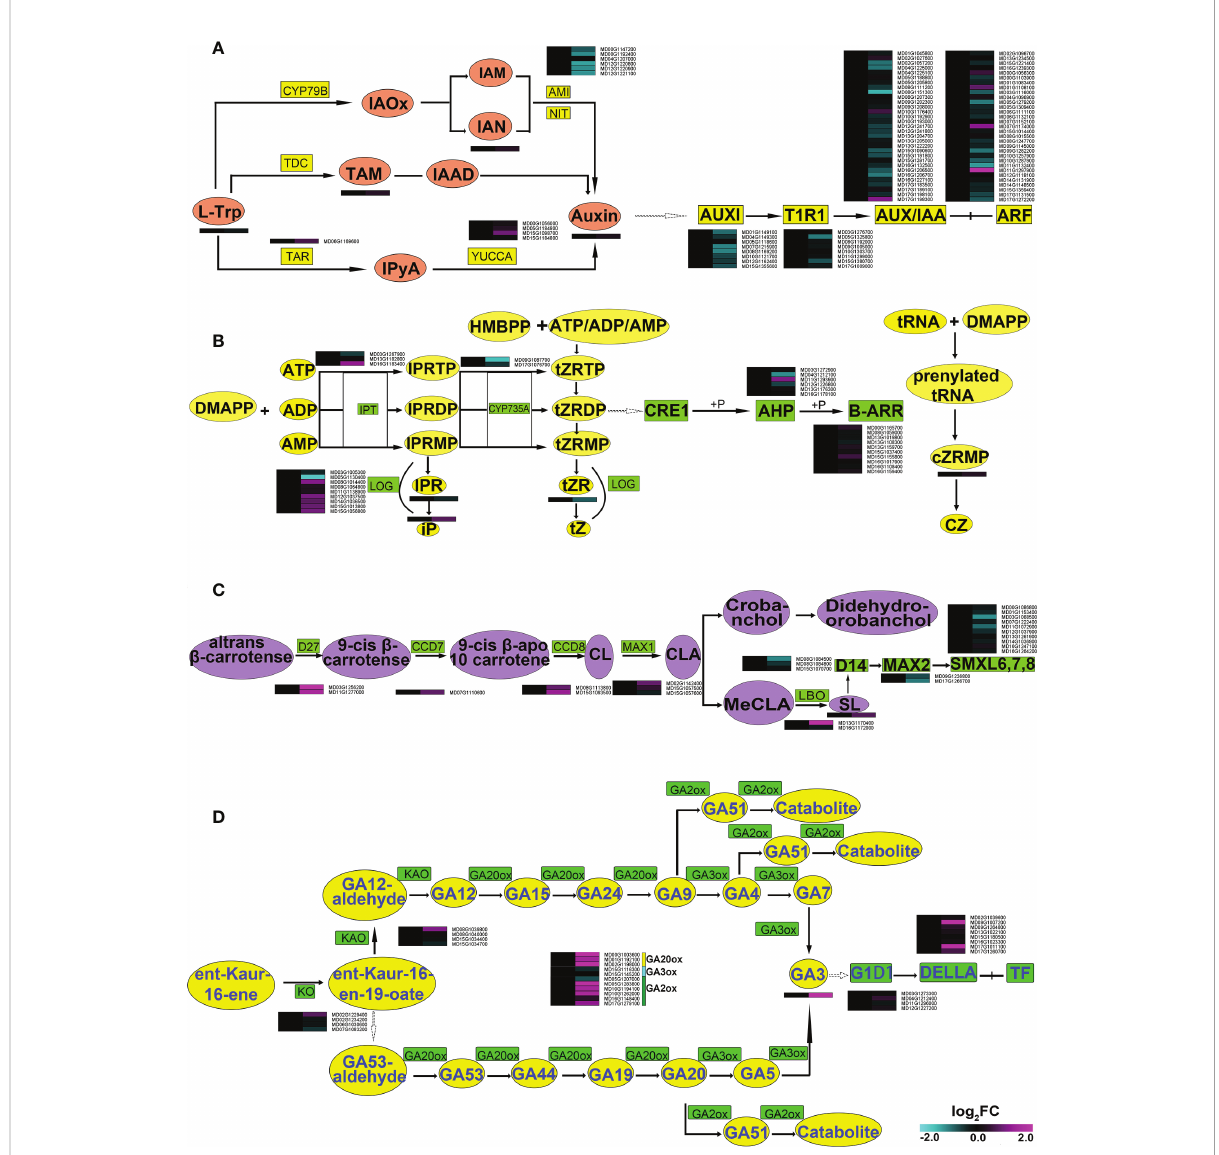
FIGURE 5 Synthesis and transduction pathways of hormones in roots of apple plants inoculated with R . irregularis for 60 days. (A) AMI1, AMIDASE 1; IAA, indole-3-acetic acid; IAAld, indole-3-acetaldehyde; IAM, indole-3-acetamide; IAN, indole-3-acetonitrile; IAOx, indole-3-acetaldoxime; IPyA, indole-3-pyruvic acid; L-Trp, L-tryptophan; NIT, nitrilase; TAR, tryptophan aminotransfearse related; TDC, tryptophan decarboxylase; CYP79B; AUX/IAA, transcriptional regulator family protein; ARF, auxin response factors; TIR1, transport inhibitor response1; (B) CTK, cytokinin; CRFs, cytokinin responsive factors; AHK3 and AHK4/CRE1, cytokinin response 1, 2; AHK2, Arabidopsis histidine kinase 2; type-B ARRs, Arabidopsis response regulators; AHPs, Arabidopsis histidine phosphotransferase proteins; IPT, isopentenyltransferase; CYP735A, cytochrome P450 monooxygenase; tRNA-speci fi c IPT, tRNA-speci fi c isopentenyltransferase; LOG, Lonely guy; iPRTP, iPR trphosphate; iPRDP, iPR diphosphate; iPRMP, iPR monophosphate; iPR, iP riboside; iP, N6-(2-isopentenyl)adenine; tZRTP, tZR 5 ′ -trphosphate; tZRDP, tZR 5 ′ -diphosphate; tZRMP, tZR 5 ′ -monophosphate; tZR, tZ riboside; tZ, trans-zeatin; cZRMP, cZR 5 ′ -monophosphate; cZ, cis-zeatin; DMAPP, Dimethylallylpyrophosphate; ATP, Adenosine triphosphate; ADP, Adenosine diphosphate; AMP, Adenosine monophosphate; HMBPP, 4-hydroxy-3-methyl-2-(E)-butenyl diphosphate; (C) DWARF27, D27; CCD7, carotenoid cleavage dioxygenase 7; MAX1, more axillary growth1; CCD8, carotenoid cleavage dioxygenase 8; SL, 5-deoxylstrigol; CL, carlactone; CLA, carlactonic acid; MeCLA, methy1 carlactonoate; LBO, oxidoreductase; (D) GA, gibberellin; KAO, ent-kaurenoic acid oxidase; KO, ent-kaurene oxidase; GA20ox, GA 20-oxidase; GA3ox, GA 3-oxidase; GA2ox, GA 2-oxidase; GID1, gibberellin insensitive dwarf1; DELLA, Gibberellic acid